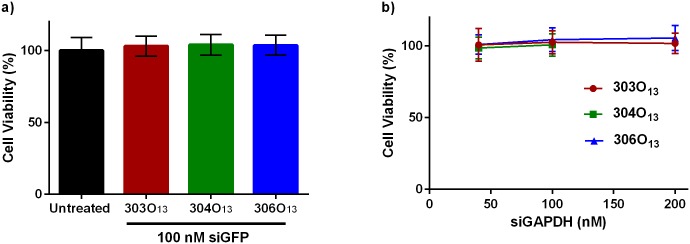
Neither A) Control (siGFP) nor B) siGAPDH loaded LNPs adversely affected Caco-2 cell viability at siRNA doses up to 200 nM.All LNPs were incubated with cells for 24 hours prior to measuring viability with an MTT assay. Error bars represent s.d. (n = 7).